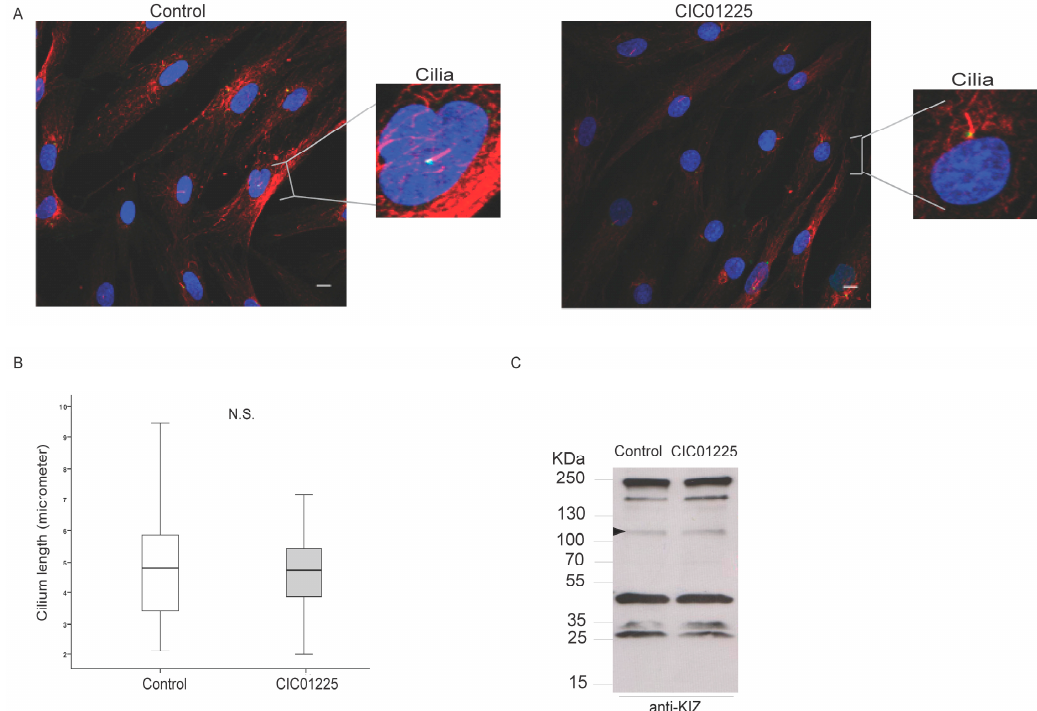
Figure 5. KIZ immunolocalization, cilia formation and immunoblot of human fibroblasts of non ‐ mutated control and patient CIC01225 with the c.52G>T (p.Glu18*) and c.119_122del (p.Lys40Ilefs*14)) mutations. The data are presented in a box plot where in the median (bar) the maximum and minimum values and the quartiles are shown. ( A ) Fibroblasts were immunolabeled with anti ‐ human KIZ antibody, anti ‐ acetylated α‐ tubulin antibody and counterstained with DAPI.